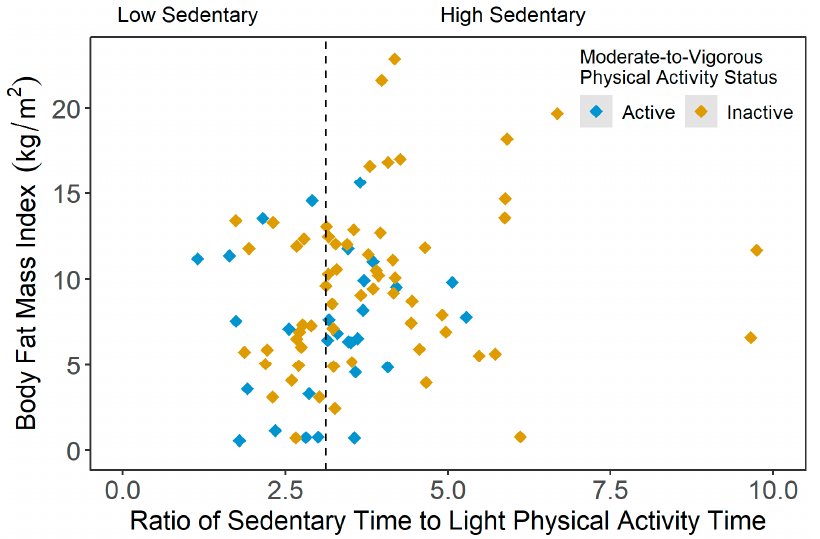
Figure 4. Scatterplot of body fat mass index (kg/m 2 ) values across the ratio of average sedentary time and average light physical activity time results, stratified by moderate-to-vigorous physical activity (MVPA) status (active = meeting 150 min/week of moderate-to-vigorous PA (MVPA); inactive = not meeting 150 min/week of MVPA).